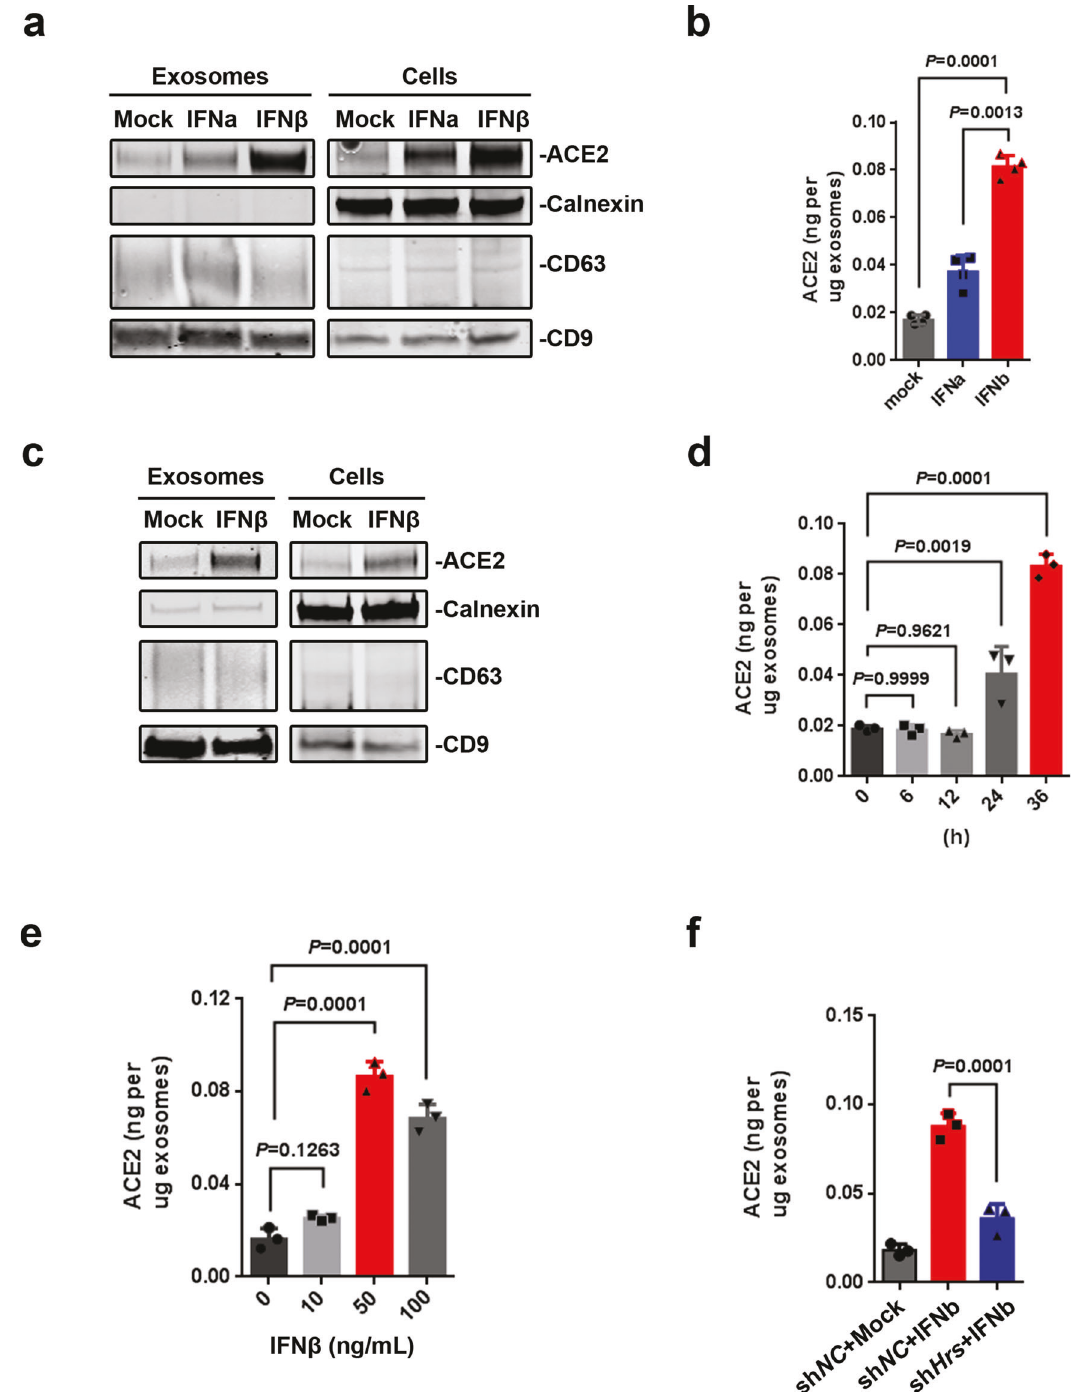
Fig. 2 Exosomal hACE2 is stimulated by IFN α / β . a Western blot analysis of the whole cell lysates and puri fi ed exosomes from HEK293T cells treated with IFN α / β (50 ng/ml for 36 h) or not (Mock). b ELISA of hACE2 on exosomes derived from HEK293T cells treated with IFN α / β (50 ng/ml for 36 h) or not. c Western blot analysis of the whole cell lysates and puri fi ed exosomes from 16HBE cells treated with IFN β (50 ng/ml for 48 h) or not (Mock). d ELISA of hACE2 on exosomes derived from HEK293T cells treated with 50 ng/ml of IFN β for different time points. e ELISA of hACE2 on exosomes derived from HEK293T cells treated with different doses of IFN β for 36 h. f ELISA of hACE2 on exosomes derived from Hrs knockdown cell line (sh Hrs -1 cell line) or control cell line treated with IFN β (50 ng/ml for 36 h) or not. Data were shown as the mean ± SD of three independent experiments, and compared using one-way ANOVA test, in which each column compared to the fi rst column of each graph. ** P < 0.01; *** P < 0.001; ns not signi fi cant